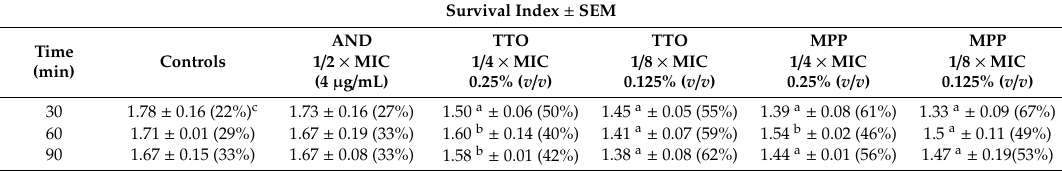
Table 2. E ff ect of sub-inhibitory concentrations of Melaleuca alternifolia (TTO) and “Mentha of Pancalieri” (MPP) essential oils in comparison with anidulafungin (AND) on intracellular killing of Candida krusei by human PMNs. The PMN killing values were expressed as a Survival Index ± SEM (standard errors of the means), calculated as the number of surviving microorganisms at 30 min (T o ) plus the number of surviving microorganisms at T x divided by the number of surviving microorganisms at T o . Survival Index ± SEM AND Time Controls 1 / 2 × MIC (min) (4 µ g /